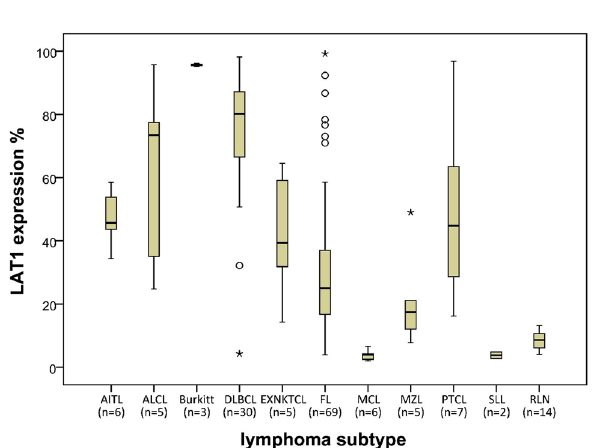
Figure 5. Comparison of LAT1 expression levels in 10 subtypes of NHL. AITL; Angioimmunoblastic T cell lymphoma, ALCL; Anaplastic large cell lymphoma, BL; Burkitt lymphoma, DLBCL; Diffuse large B cell lymphoma, ENKTCL; Extranodal Natural killer and T cell lymphoma, FL; Follicular lymphoma, MCL; Mantle cell lymphoma, MZL; Marginal zone lymphoma, PTCL; Primary T cell lymphoma, SLL; Small lymphocytic lymphoma, RLN: reactive lymph